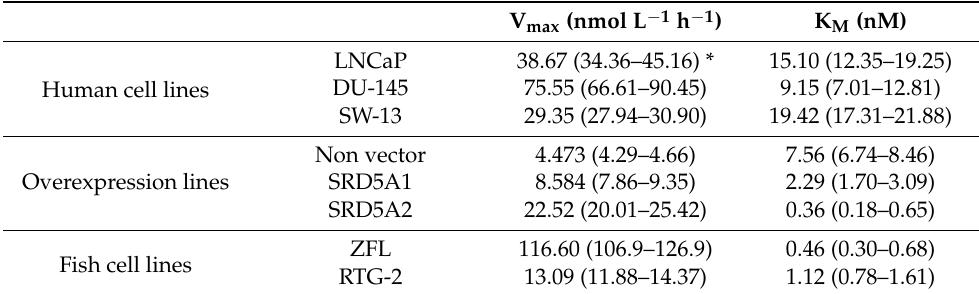
Table 2. V max and K M value for testosterone in each cell line.